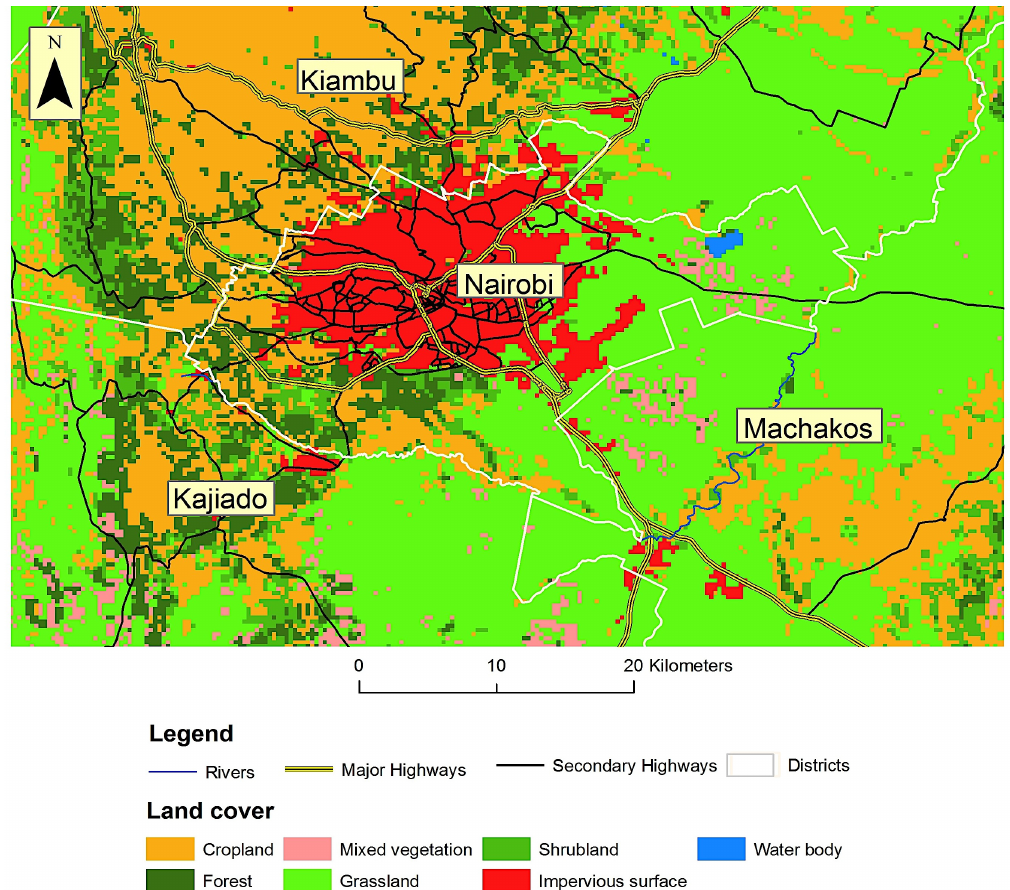
Figure 1. Study area: Nairobi, Kenya, and its surrounding counties.